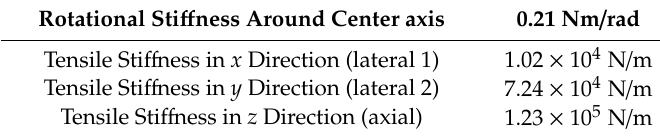
Table 13. Main sti ff ness characteristics of lifetime setup at beginning of life (average of three